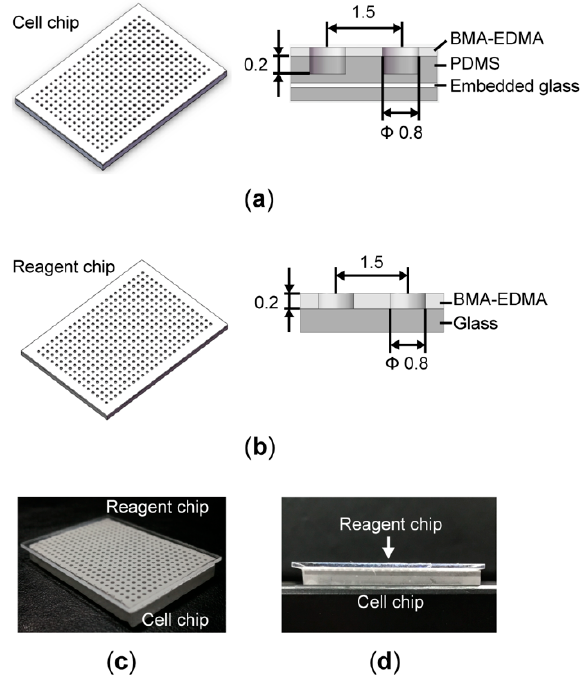
Figure 1. High-throughput superhydrophobic cell culture system. ( a ) Schematic of the cell chip with a 384-microwell array. The cross-sectional view of the chip shows the polydimethylsiloxane (PDMS) microwell and has a diameter of 0.8 mm, a depth of 0.2 mm, and a spacing of 1.5 mm. A thick layer of superhydrophobic polymers (BMA-EDMA) is attached to the top surface of the microwell array. A piece of glass coverslip is embedded into the PDMS as a support frame to prevent shrinkage of the microwell array. ( b ) Schematic of the reagent chip. The cross-sectional view of the chip shows a 0.2 mm-thick layer of BMA-EDMA polymers attached to a piece of glass. ( c ) Photo of a reagent chip aligned with a cell chip. ( d ) Photo of a reagent chip sandwiched with a cell chip.